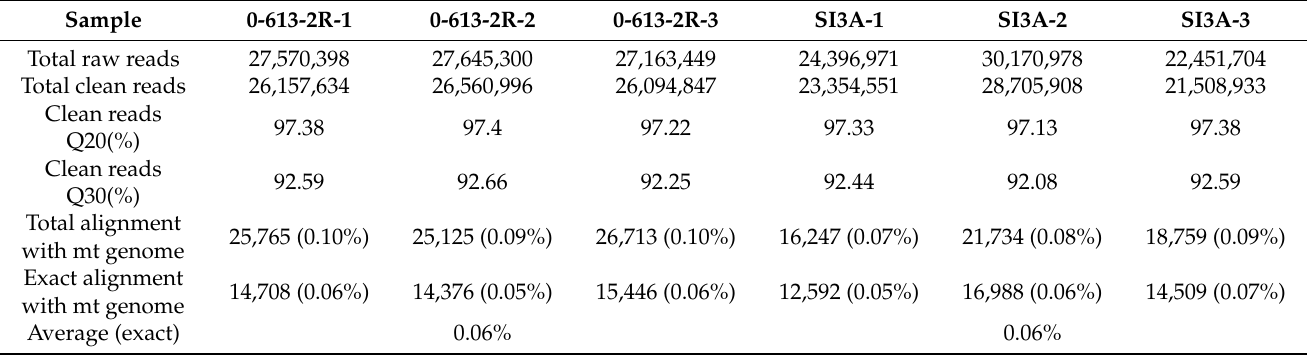
Table 4. Mapping results for Illumina RNA-seq data to mitochondrial